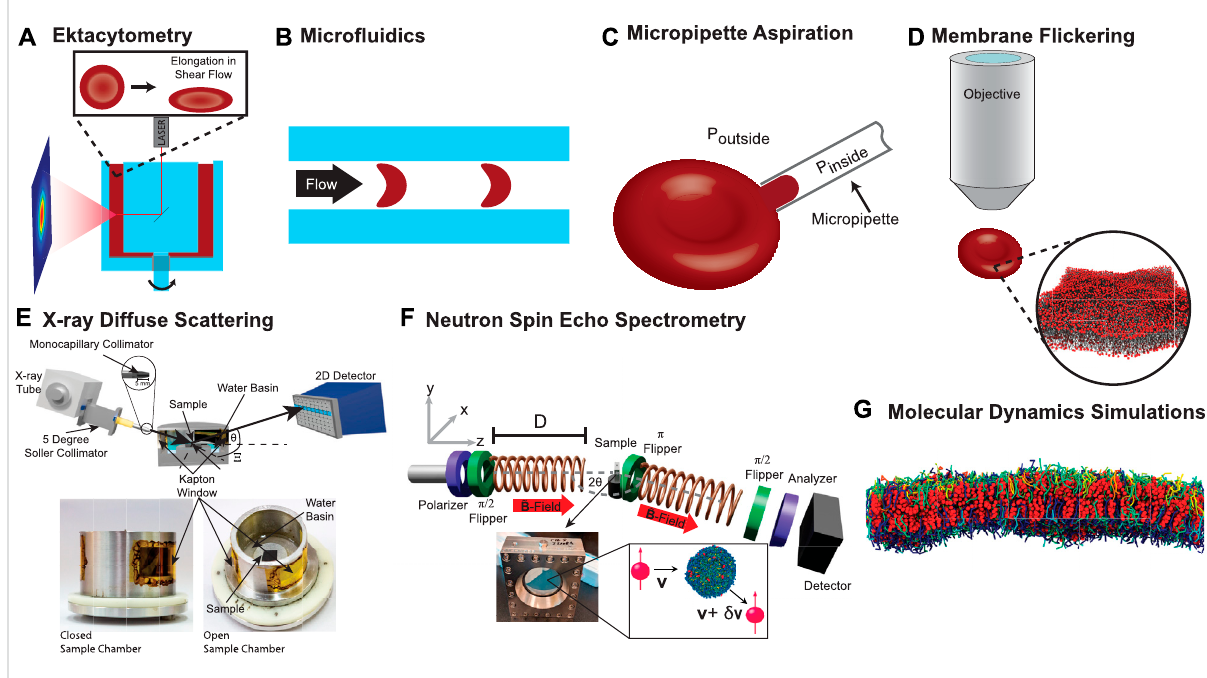
FIGURE 5 RBC ’ sdeformabilitycanbeprobedindifferenttechniques: (A) EktacytometryopticallyprobestheelongationofRBCinshear fl ow. (B) TheRBC ’ s deformability can also be determined by visually inspecting single-cell elongation when the cells pass through microcapillaries of a micro fl uidic device. (C) InMicropipetteaspiration,asmallbulgeisformedbymeansofapressuregradientbetweenthepipetteandthesurroundingmedium.The deformation is then visually inspected under a microscope and material properties can be determined from a shape analysis. (D) Membrane fl uctuations can be observed optically and the fl uctuation spectrum can be calculated and allows the determination of the membrane ’ s material characteristics. (E) X-ray diffuse scattering probes the membrane ’ s bending modulus of solid supported, tension-free RBC cm . Undulating membranes result in off-specular diffuse scattering signal that varies with the membrane ’ s mechanical properties. (F) Neutron spin echo spectrometry probes the membrane ’ s dynamical properties by measuring the energy transfer of scattered neutrons. (G) Molecular Dynamics (MD) simulations allow direct access to the molecules trajectories and fl uctuation